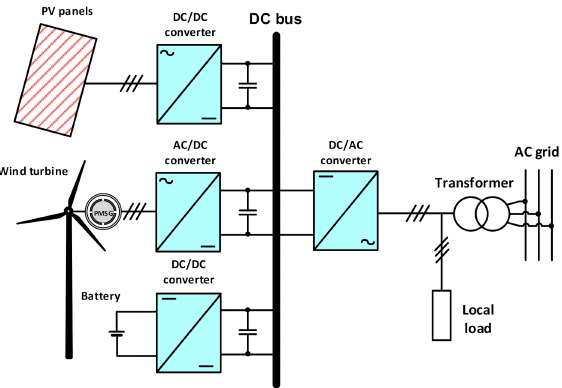
Figure 1. Scheme of grid-connected hybrid renewable energy system (HRES) with common DC